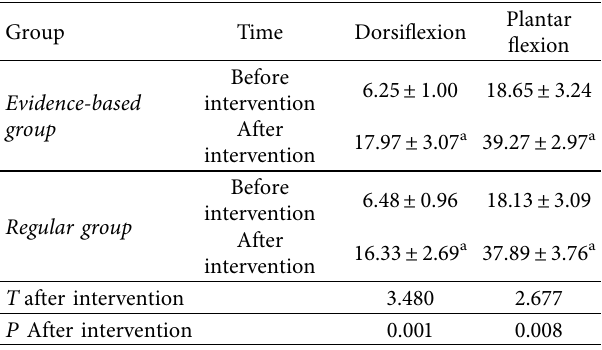
Figure 1: Rehabilitation time of the two groups of patients. Table 2: Comparison of active ankle range of motion before and after intervention in the two groups of patients ( n � 75, ° , x ± s ).